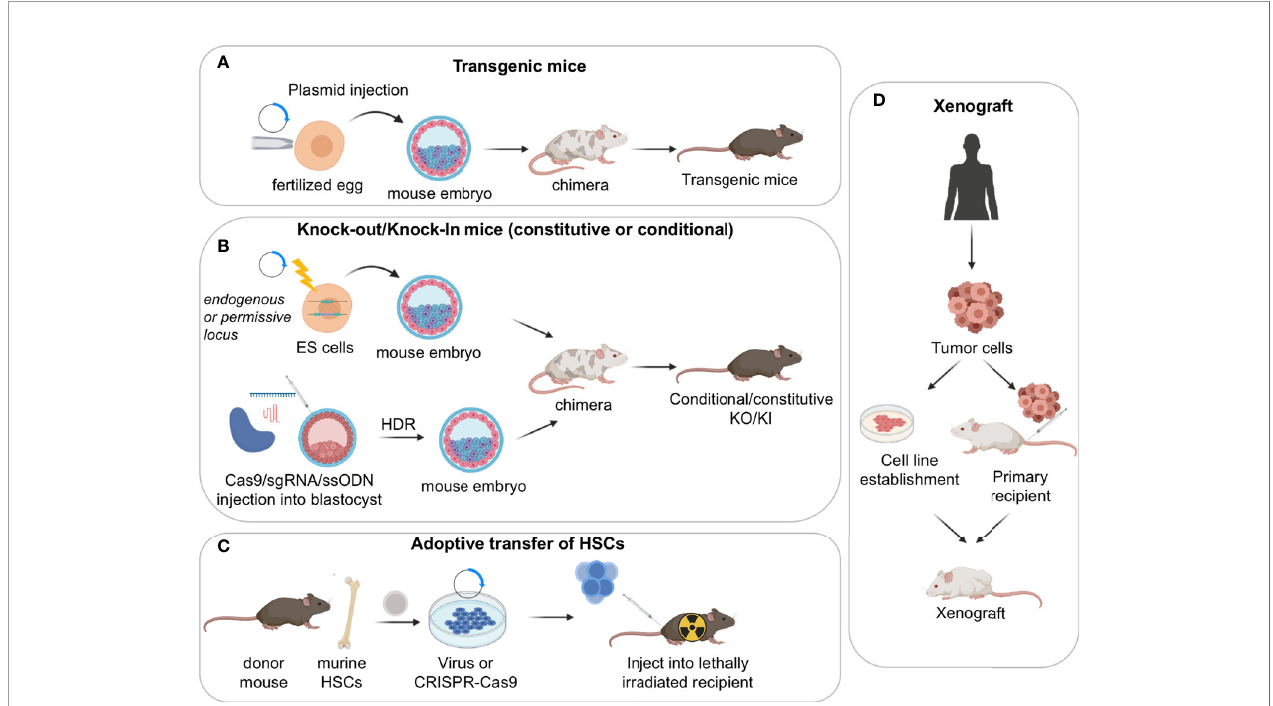
FIGURE 2 | Approaches used to generate mouse models of GC derived lymphomas. (A) Transgenic mouse models; (B) constitutive or conditional knock-out/ knock-in mouse models, obtained via homologous recombination in ES cells or CRISPR-Cas9 mediated genome editing; (C) adoptive transfer of HSCs. (D) Xenograft mouse models of human lymphoma cells can be established by injection of stable cell lines or by direct implantation of primary tumor samples into recipient immunosuppressed or humanized mice. Serial passaging of the engrafted tumors may be necessary to achieve high xenotransplantation ef fi ciency. These models are particularly useful for the pre-clinical evaluation of novel therapeutic combinations in vivo